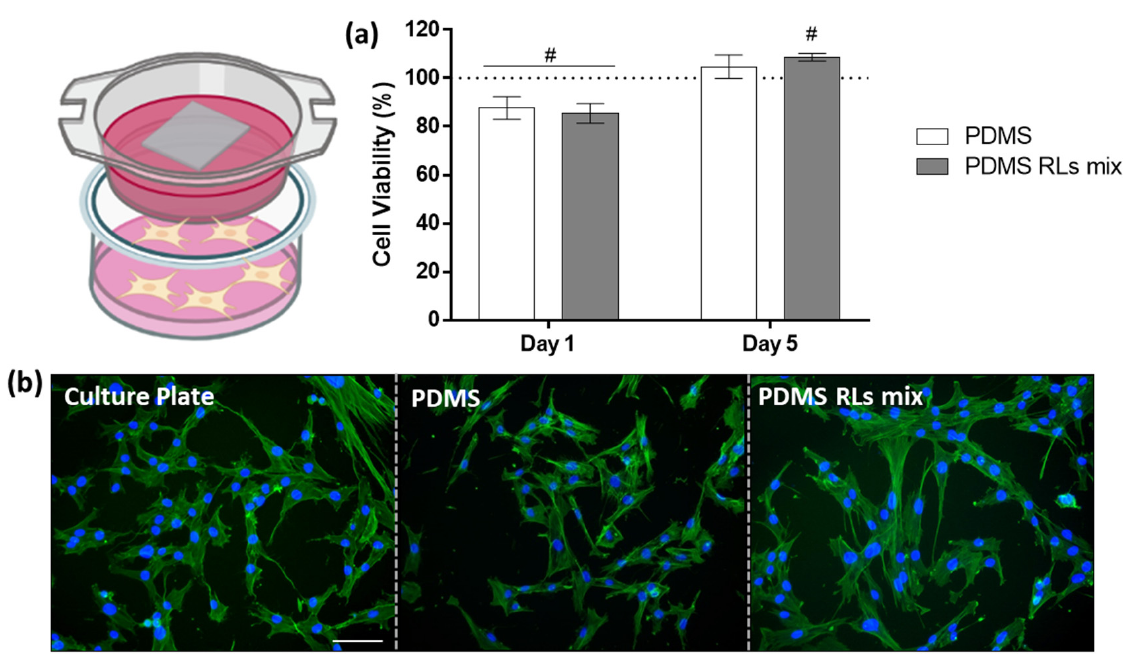
Figure 6. HDF cultures were seeded on the bottom of culture plates and incubated indirectly in the presence of PDMS materials: ( a ) cell viability/metabolic activity assessed by resazurin assay; cells seeded over the culture plate were used as control, set as 100%; # significantly different from control; p ≤ 0.05; ( b ) representative fluorescence images of cell morphology of 24 h HDF cultures; actin cytoskeleton was stained in green while the nuclei were counterstained in blue; scale bar: 100 µm.